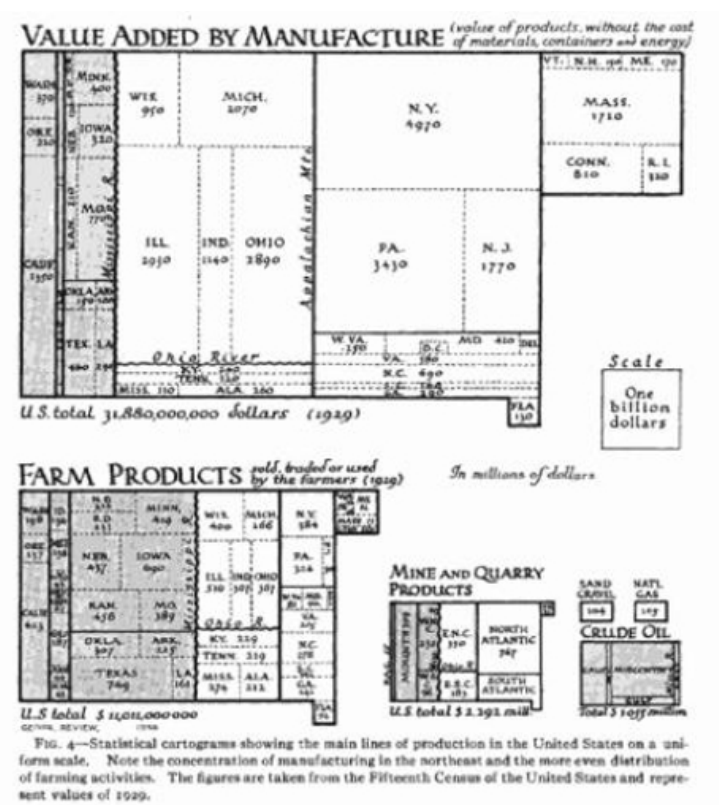
Fig. 3. Rectangular cartogram. The area of rectangles is proportional to the value of US production in 1929 (E. Raisz